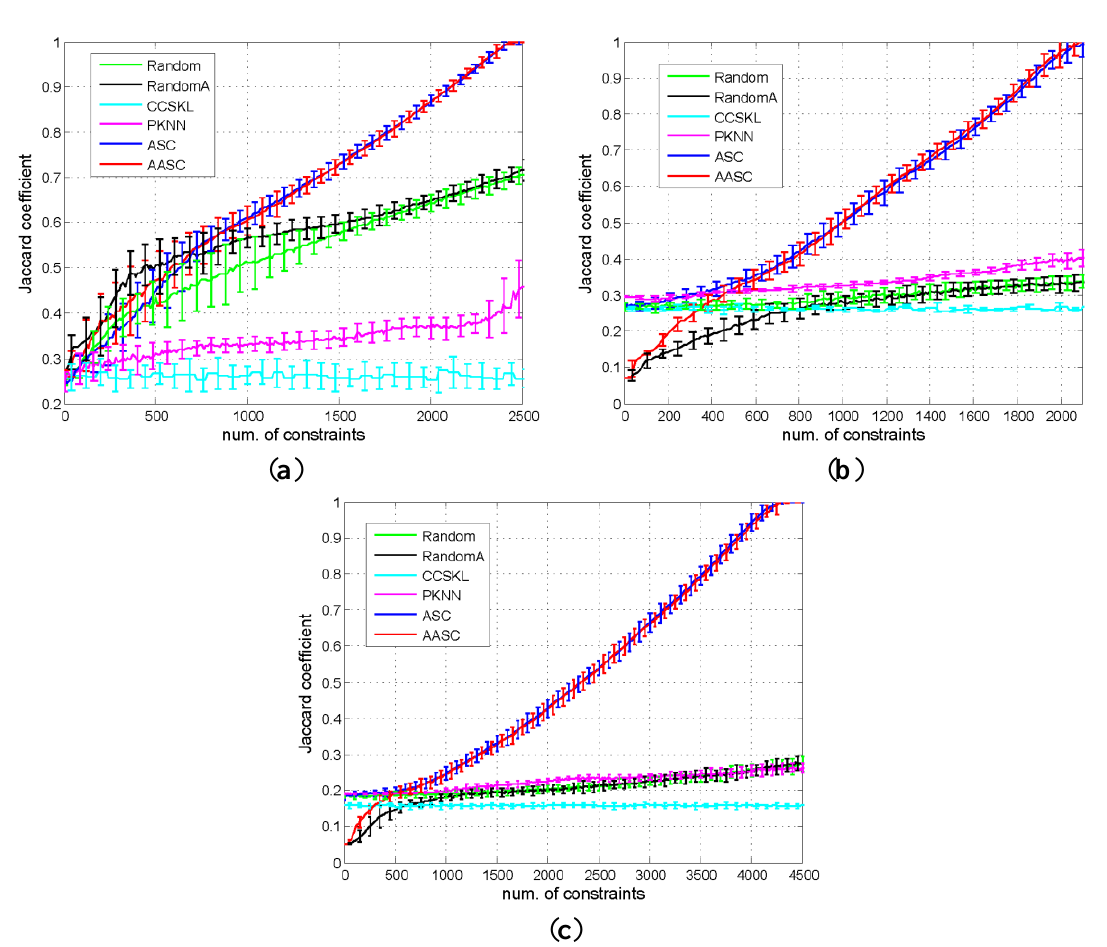
Figure 11. Clustering accuracy as evaluated using the Jaccard coefficient. We ran each algorithm 50 times, and the results are shown as the means and standard deviations of the Jaccard coefficient: ( a ) Beijing; ( b ) WHU-RS; and ( c )